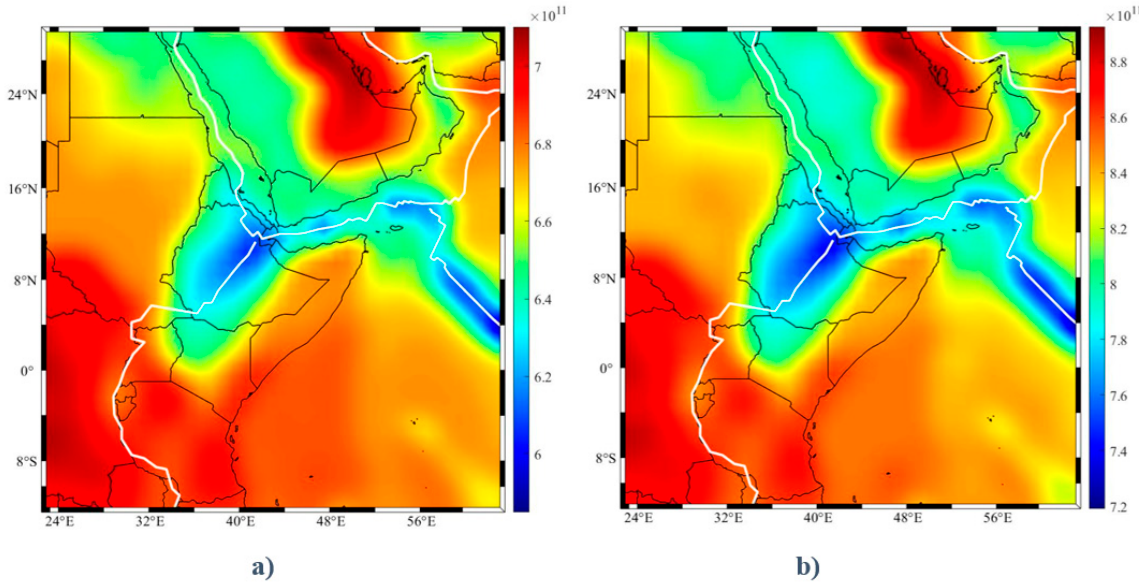
Figure 4. Map of ( a ) µ (Pa) and ( b ) γ (Pa): white lines are the boundaries of the plates from model PB2002 [26].